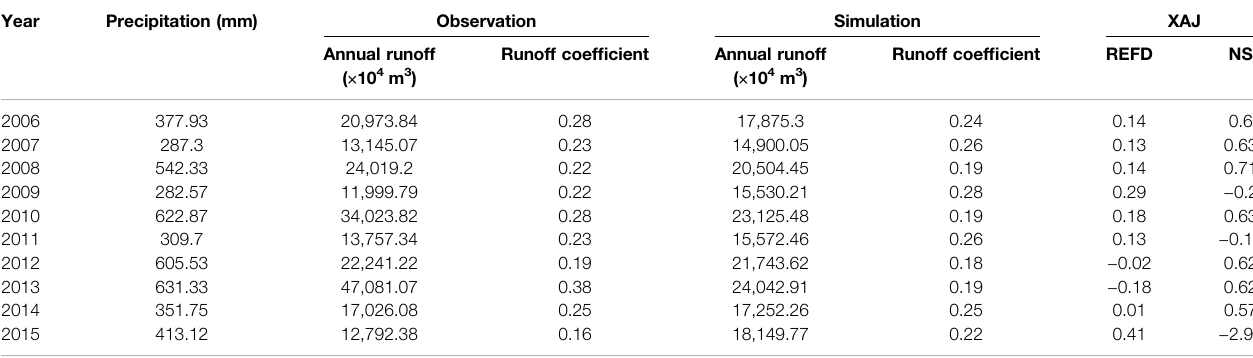
TABLE 4 | The simulation of daily model for the XAJ model.